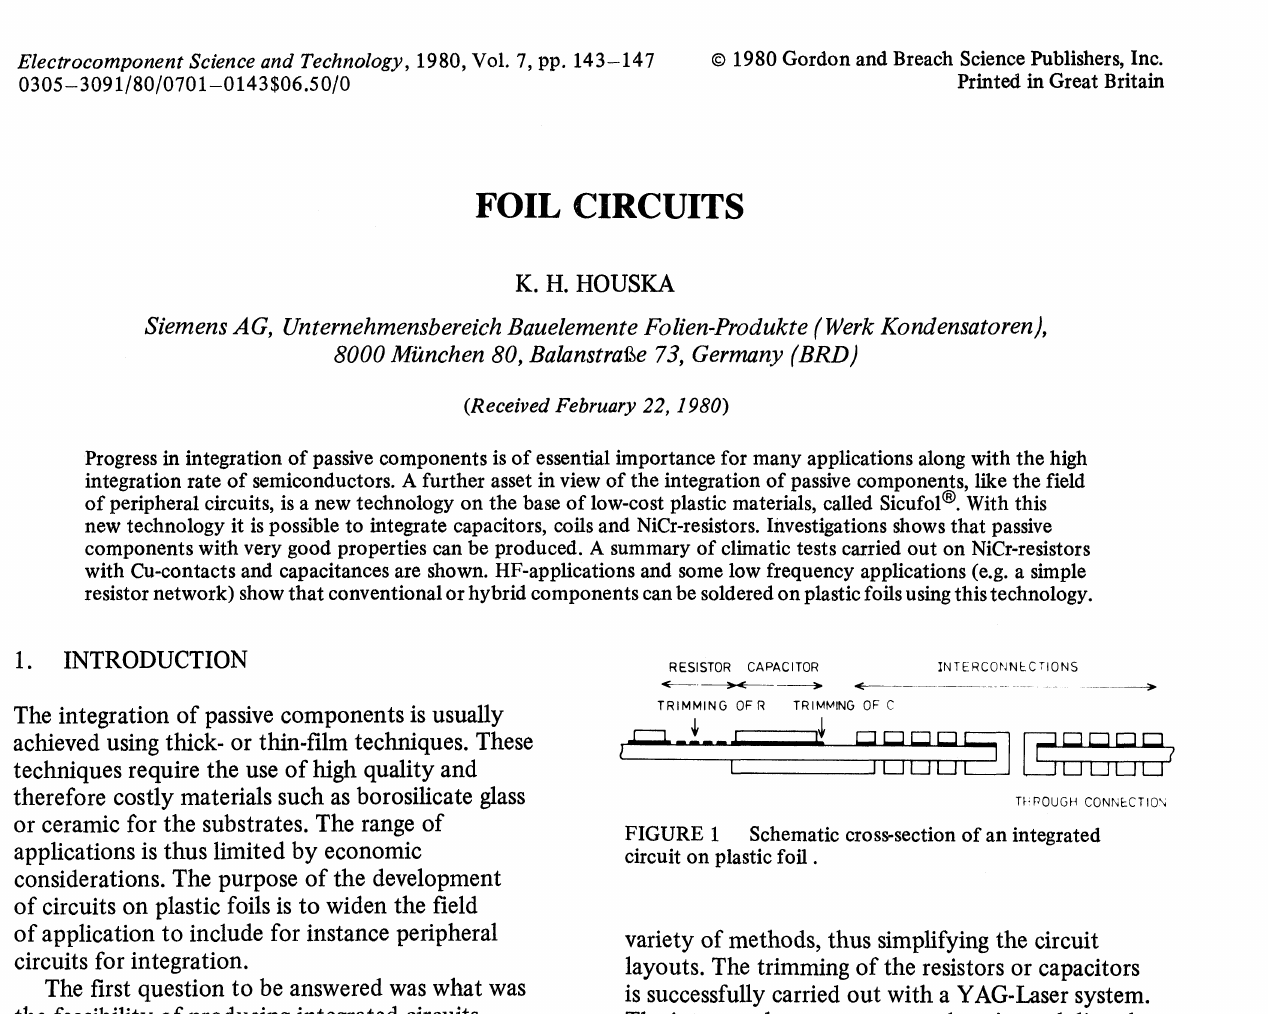
FIGURE Schematic cross-section of an integrated circuit on plastic